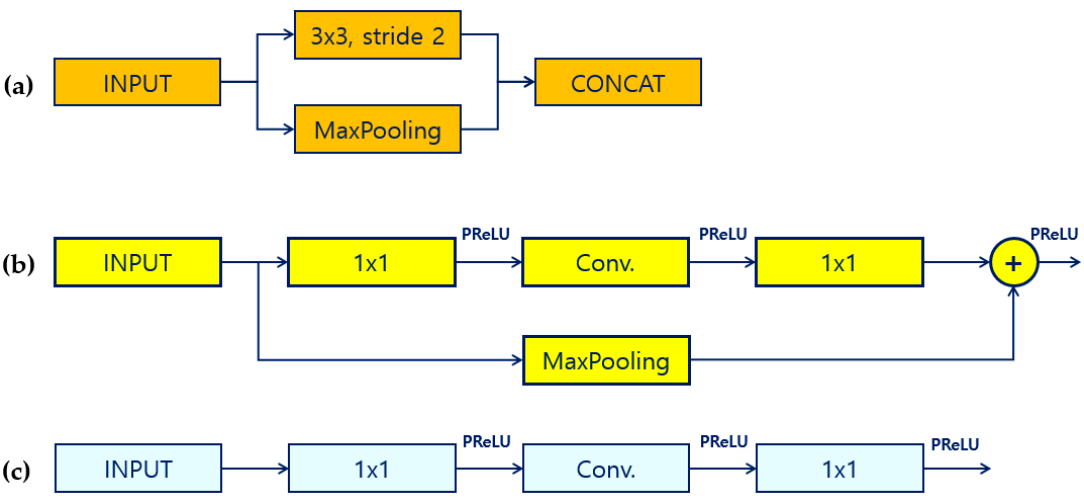
Figure 2. Operation structure of lightweight efficient neural network initial block and bottleneck module. ( a ) Initial module, ( b ) bottleneck module of downsampling operation, and ( c ) bottleneck module of dilated and asymmetric convolution.